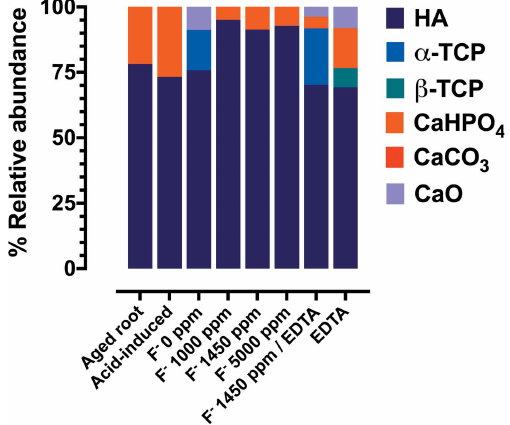
Figure 7 The diversity shift of calcium derivatives in the presence of F (cid:2) and Ca 2+ in the environment. Relative abundance (%) of the following calcium species: hydroxyapatite, (cid:2) -TCP, (cid:3) -TCP, CaHPO 4 , CaCO 3 , CaO found in each treatment